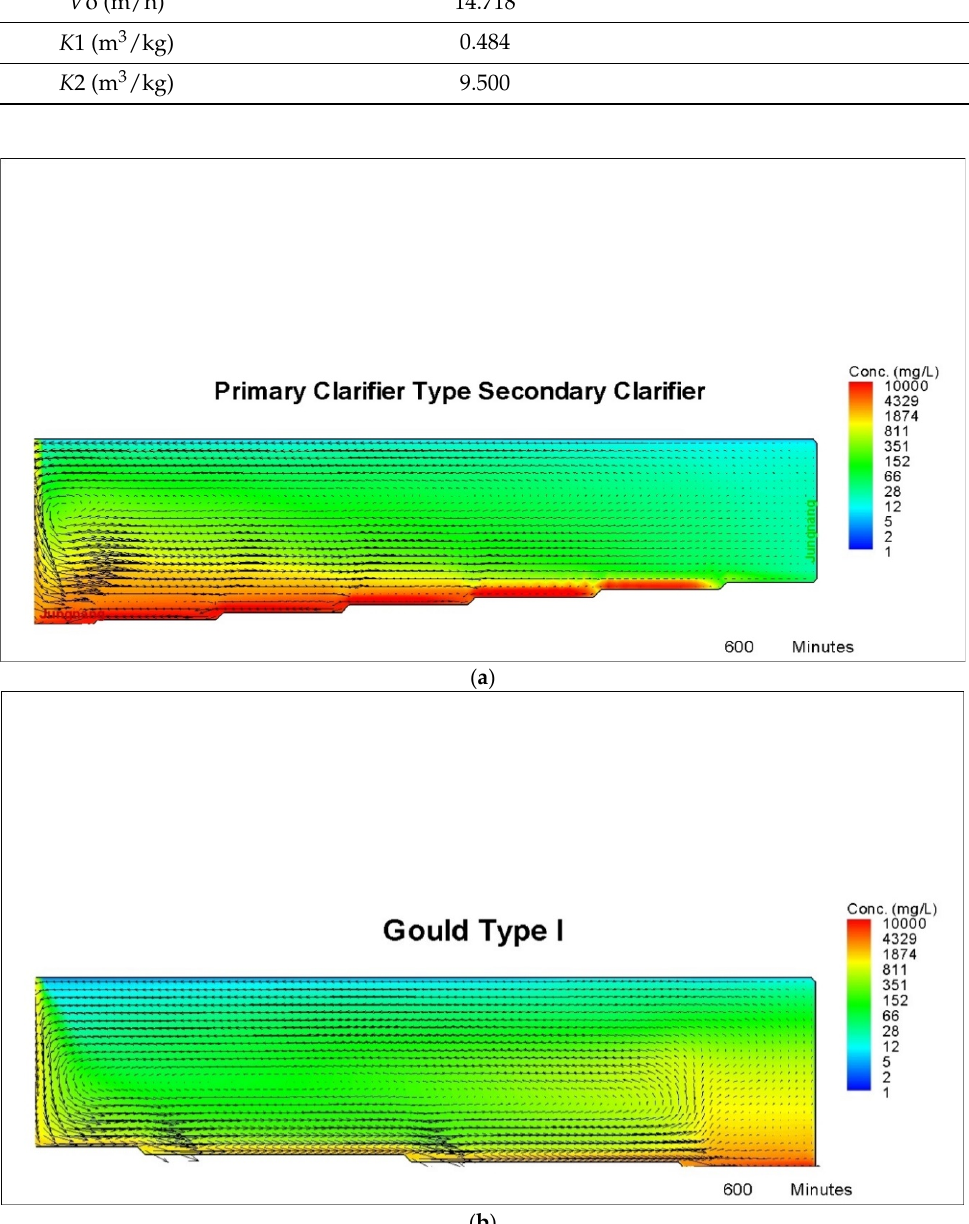
Figure 7. ( a ) Two-dimensional SS concentration contour profile for the secondary clarifier at plant A. ( b ) Two-dimensional SS concentration contour profile for the secondary clarifier at Plant